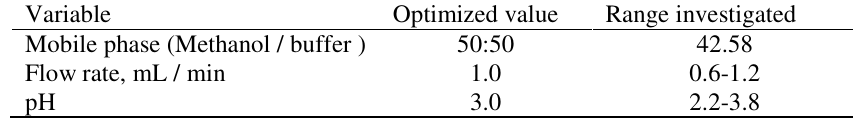
Table 3 . Chromatographic conditions and range investigated during robustness testing.